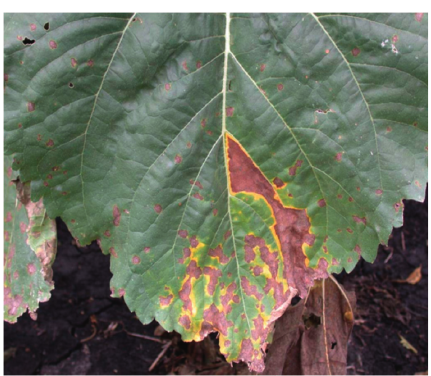
Figure 4: Verticillium